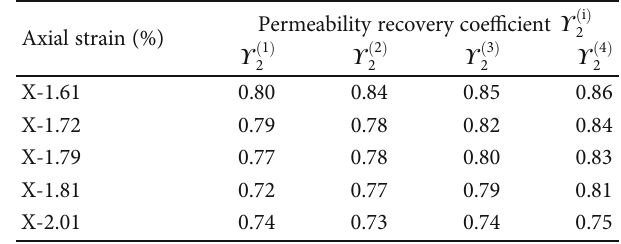
Table 13: The permeability recovery coe ffi cient of water-bearing specimen.